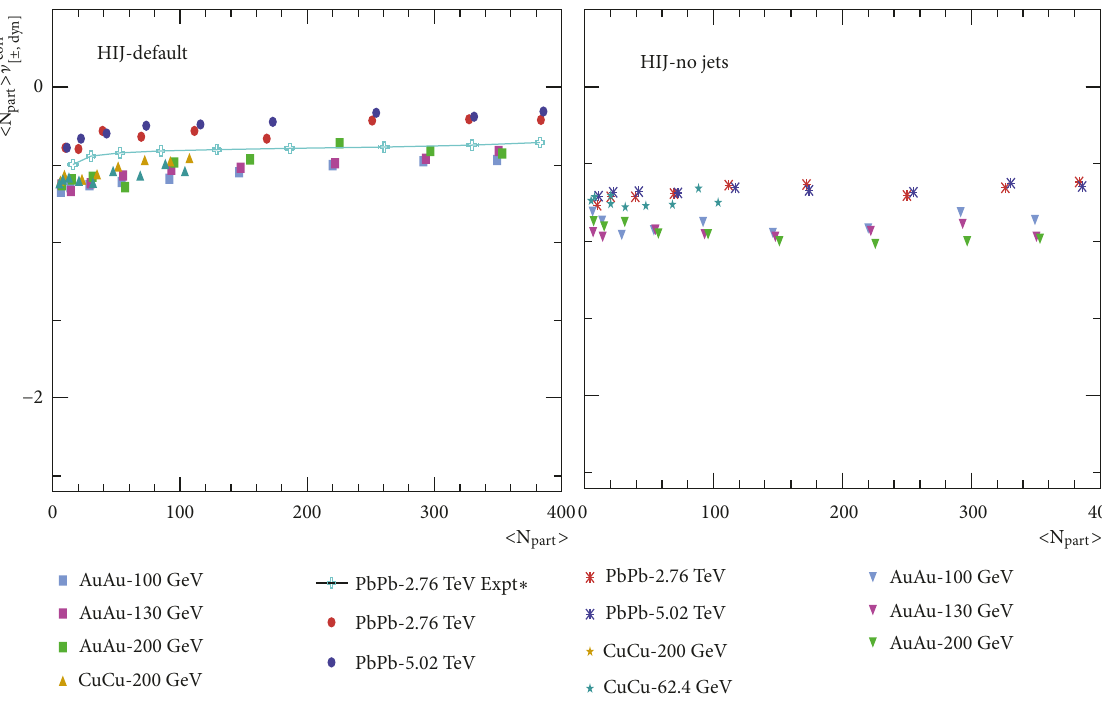
Figure 6: Variations of (𝑁 𝑝𝑎𝑟𝑡 ) ] 𝑐𝑜𝑟𝑟 [+−,𝑑𝑦𝑛] with 𝑁 𝑝𝑎𝑟𝑡 for the two sets of HIJING